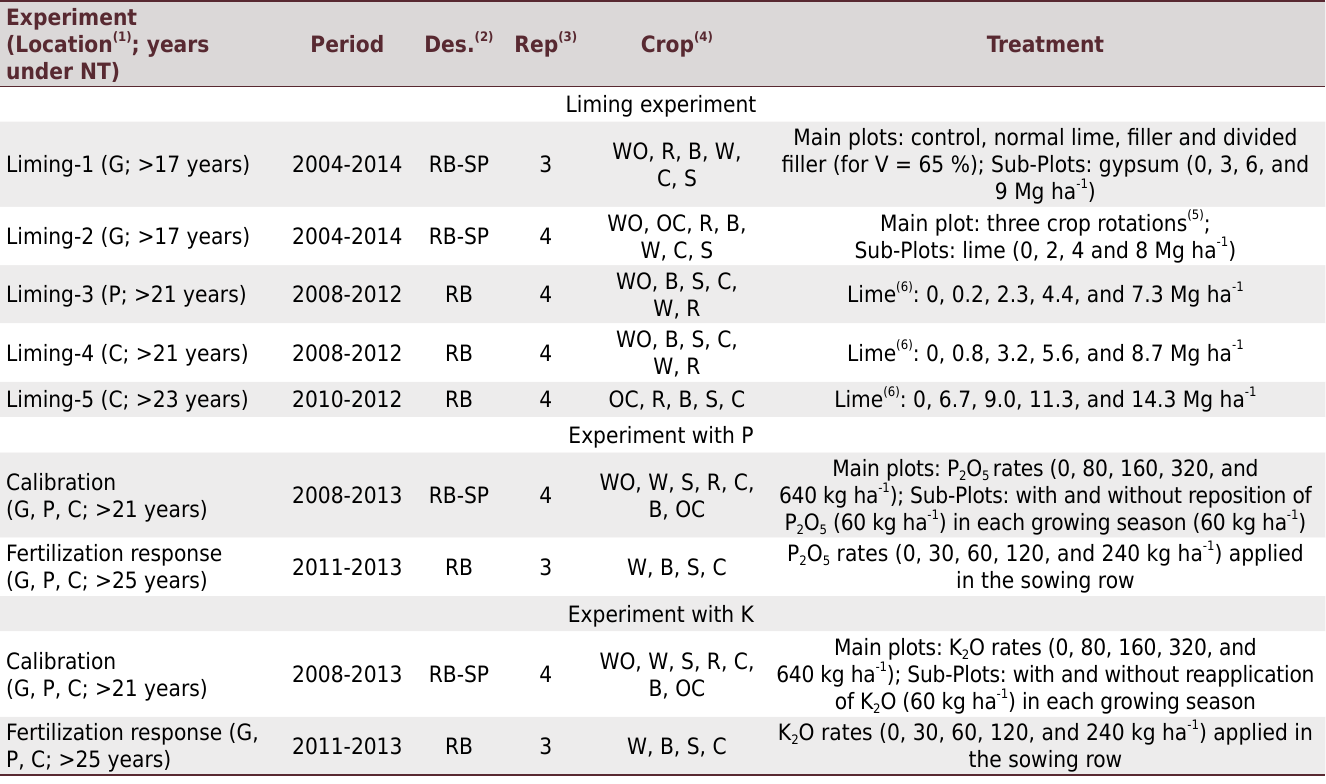
Table 1. Characteristics of the experiments including location, duration, experimental design, number of replicates, crops and treatments